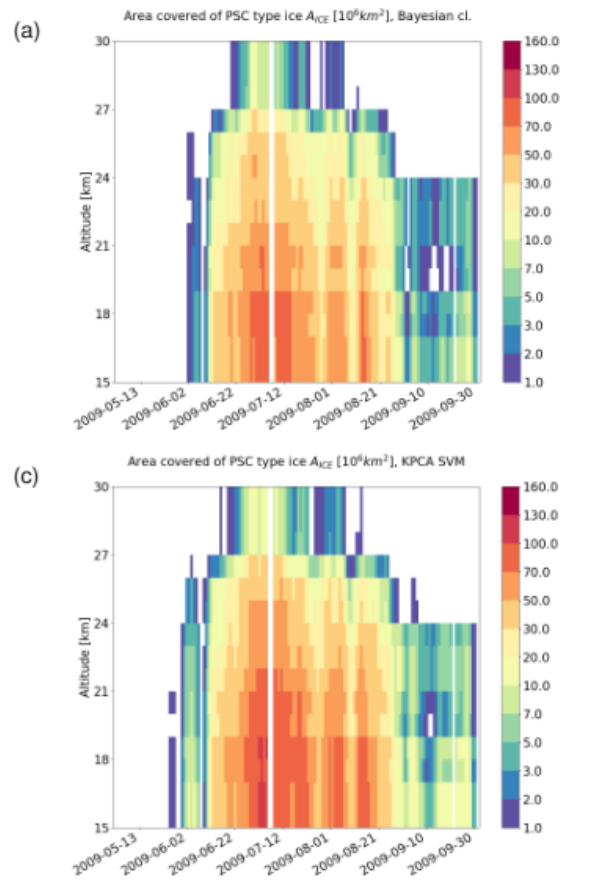
Figure 12. Same as Fig. 11 but for